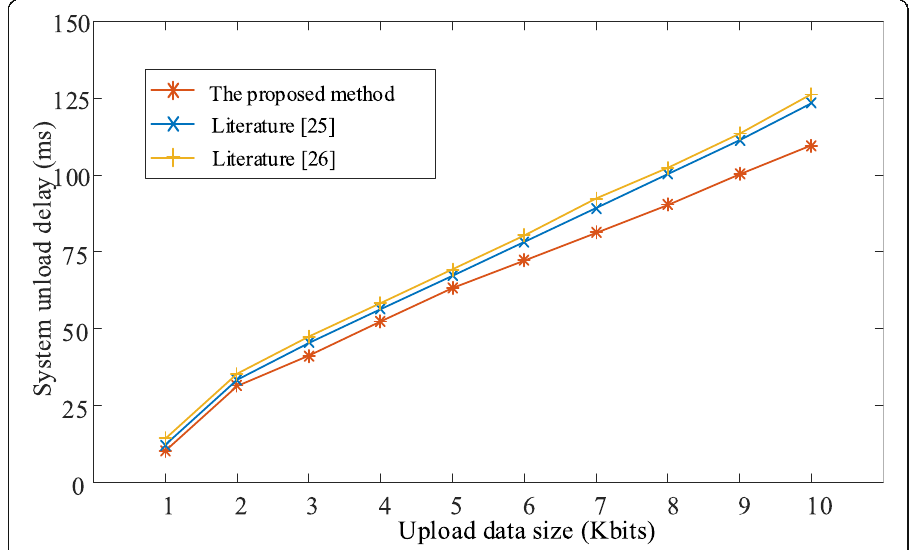
Fig. 7 Relationship between time delay and the size of uploaded